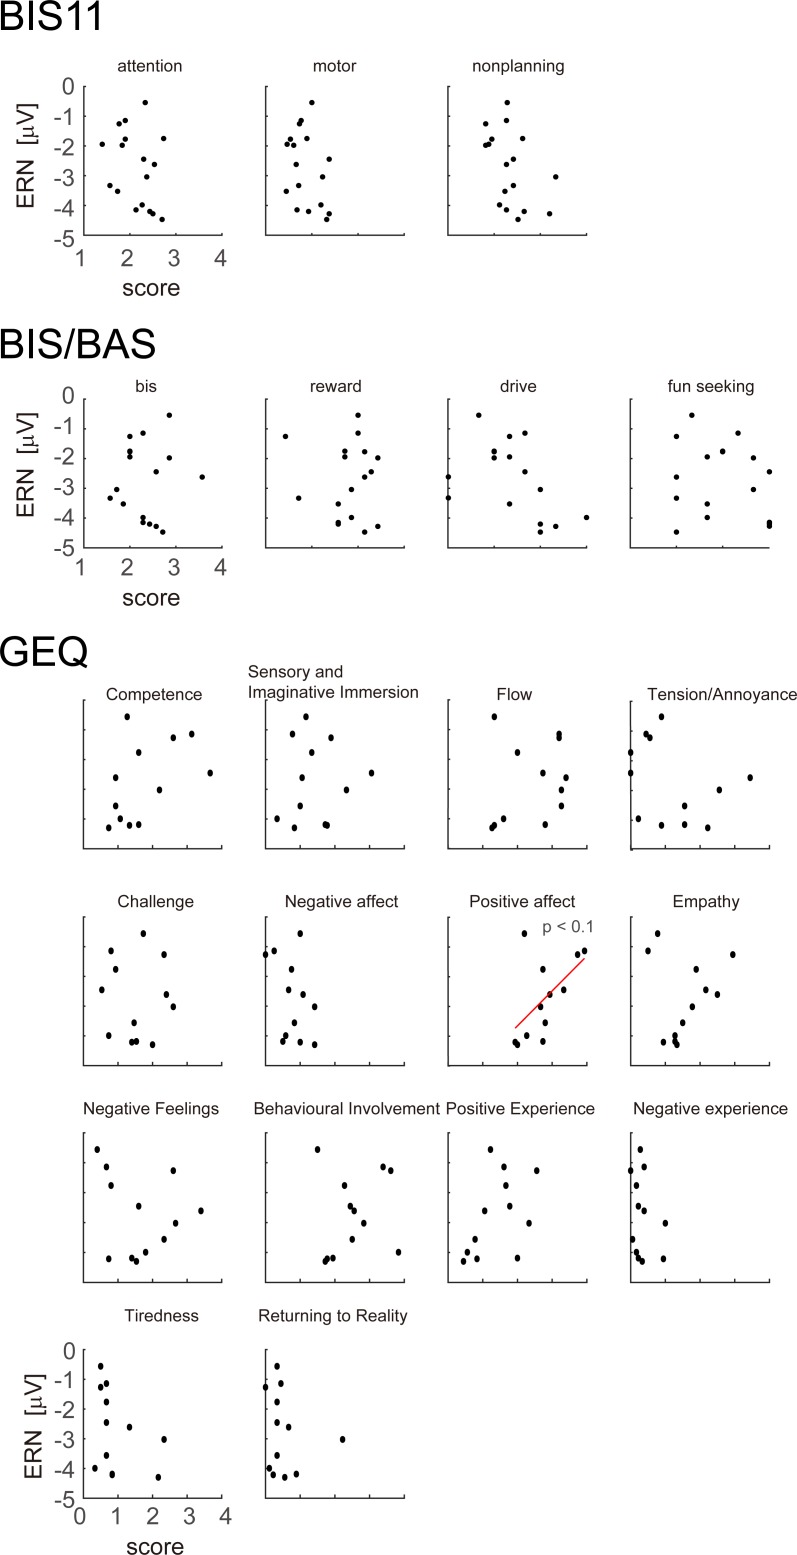
Correlation of ERN amplitude before swinging strikes with scores from the self-evaluation questionnaires (BIS11, BIS/BAS, and GEQ).We found a trend for ERN amplitude to be smaller for higher values of ‘positive affect’.